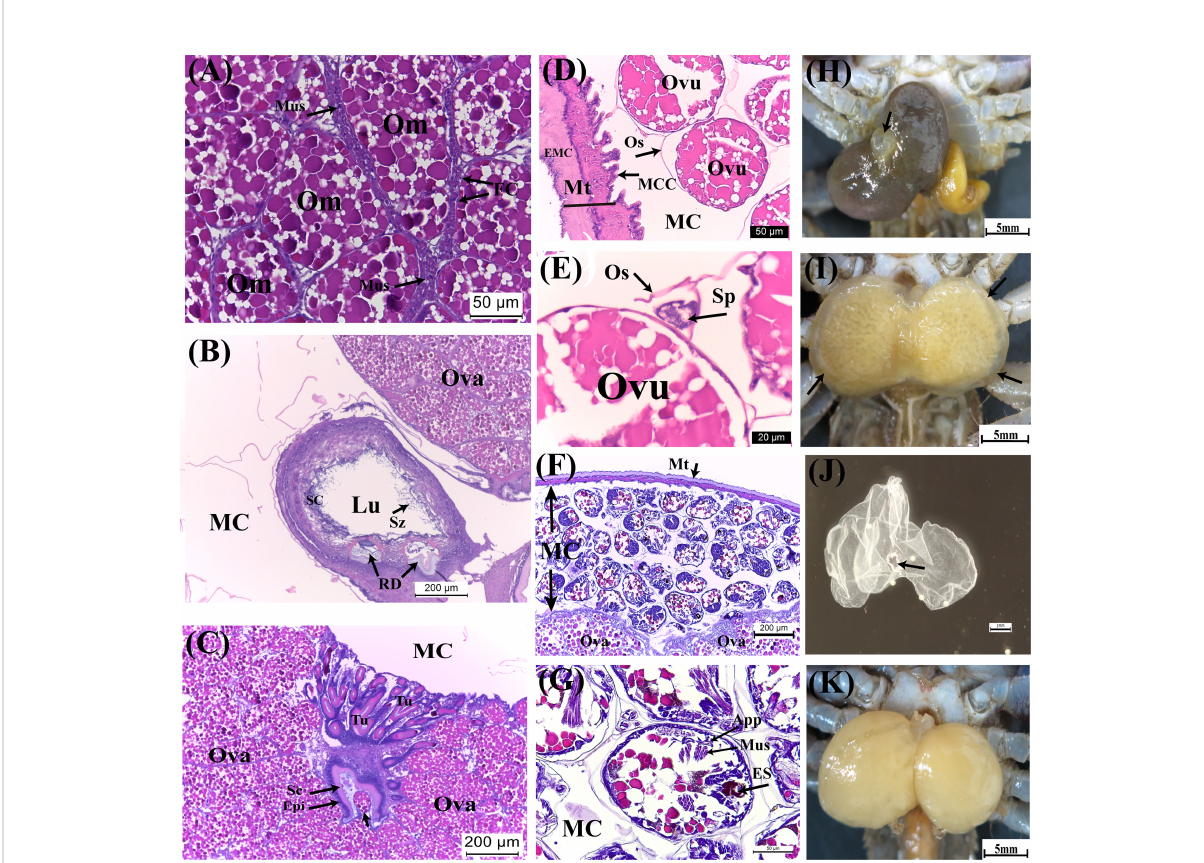
FIGURE 5 Developmental characteristics of the externa of Polyascus planus parasitizing the thukuhar shore-crab ( Metopograpsus thukuhar ) in the Yellow and Brown stages. Externa reaching Yellow stage is fully mature with (A) mature oocytes encircled by the muscle cells, (B) mature spermatozoa present in the male receptacle, and (C) the tubular lumen of the colleteric gland lined with secretion. (D, E) Following ovulation, ova enclosed by ovisac, to which ball of sperms attaches, appear within the mantle cavity. (F, G) Embryos inside the mantle cavity of the externa in Brown stage are actively undergoing organogenesis. (H) A raised mantle opening (black arrow) is indicative of imminent release of hatched nauplii. (I) After the peak of larval release, the externa returns to the Yellow stage with an opaque rim (black arrows), pro fi ling the now vacated mantle cavity. After the mantle cavity cuticle molts, (J) the exuviae is extruded via the mantle opening, (K) followed by return of the externa to Yellow stage ready for another round of reproduction. App, appendage; ES, eye spot; Ovu, ovum; Sp, sperm ball; Sz, spermatozoa. Other abbreviations are as indicated in Figures 2 –